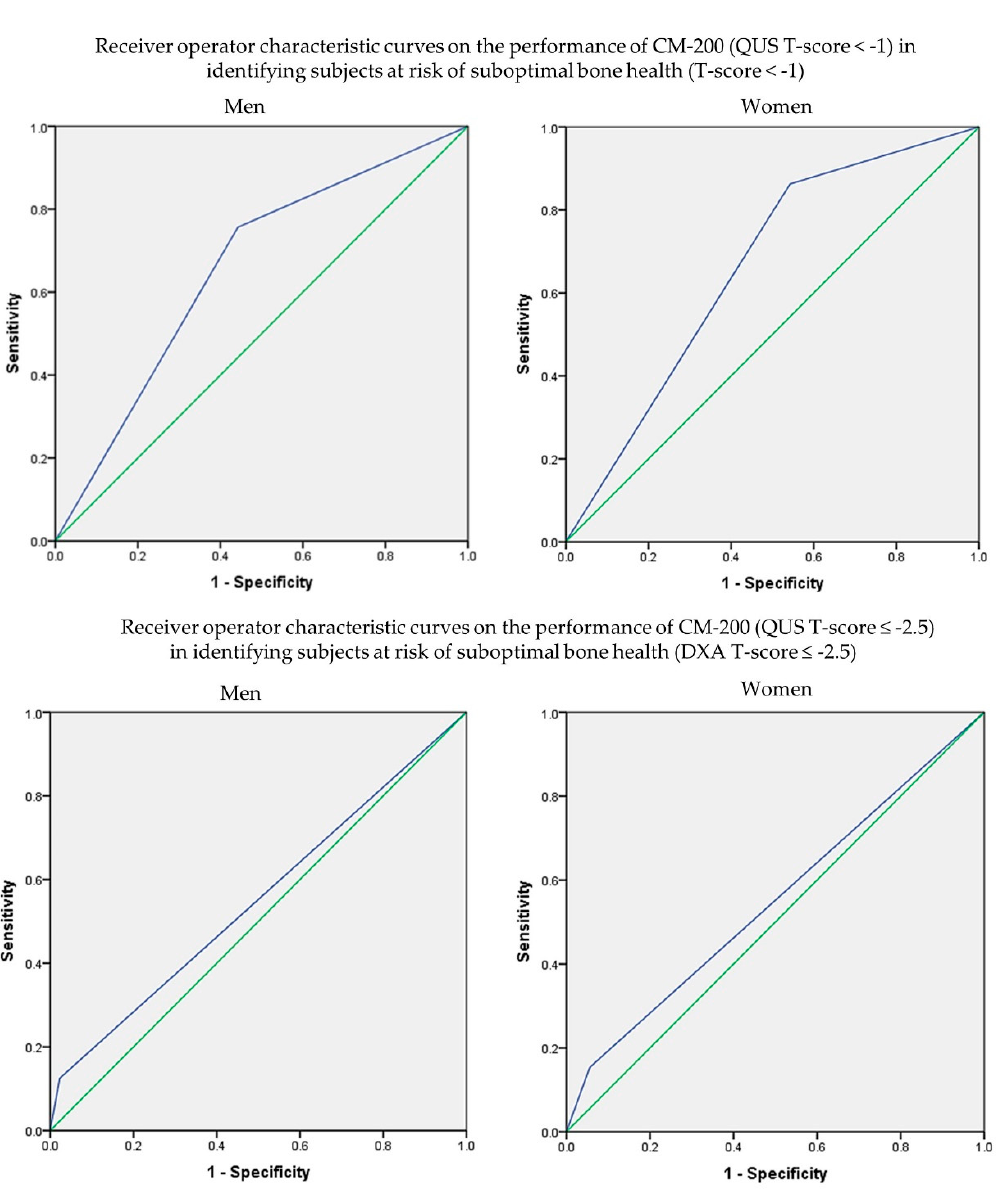
Figure 1. Receiver operating characteristic curves of QUS in identifying the risk of osteoporosis with reference to DXA.